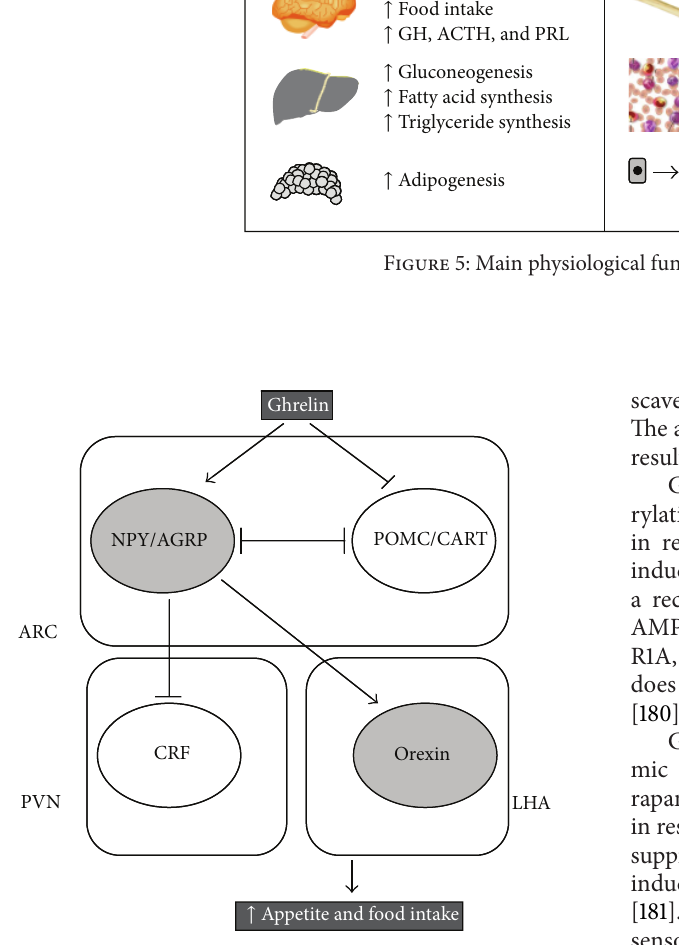
Figure 6: Main hypothalamic pathways involved in ghrelin- induced food intake. Arrows and lines indicate stimulation and inhibition, respectively. AGRP: agouti-related protein; ARC: arcuate nucleus; CART: cocaine- and amphetamine-regulated transcript; CRF: corticotrophin-releasing factor; LHA: lateral hypothalamic area;NPY:neuropeptideY;POMC:proopiomelanocortin;andPVN: paraventricular